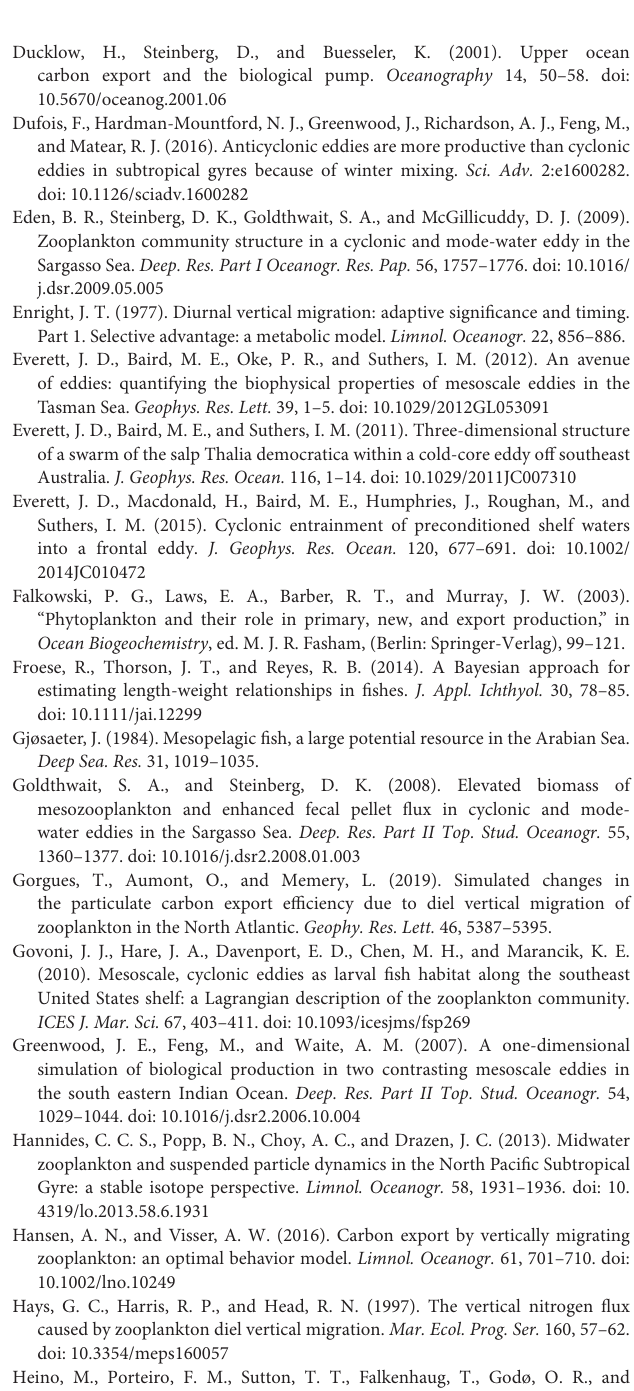
TABLE S8 | Day/night avoidance variability correction and overall net avoidance calculation for migratory micronekton carbon fluxes (mg C m − 2 d − 1 ) out of the MLD in the B-CCE and WCE, and carbon recycling (values in brackets) in the R-WCE. Micronekton biomass is first corrected for diel differences in net avoidance (see the section “Vertical Migration and Active Carbon Transport”), and then for overall micronekton net avoidance assuming a net efficiency of 14% (Koslow et al., 1997). MF = mortality flux, RF = respiratory flux, EF = excretory flux, and GF = gut flux. DATA SHEET S1 | Raw